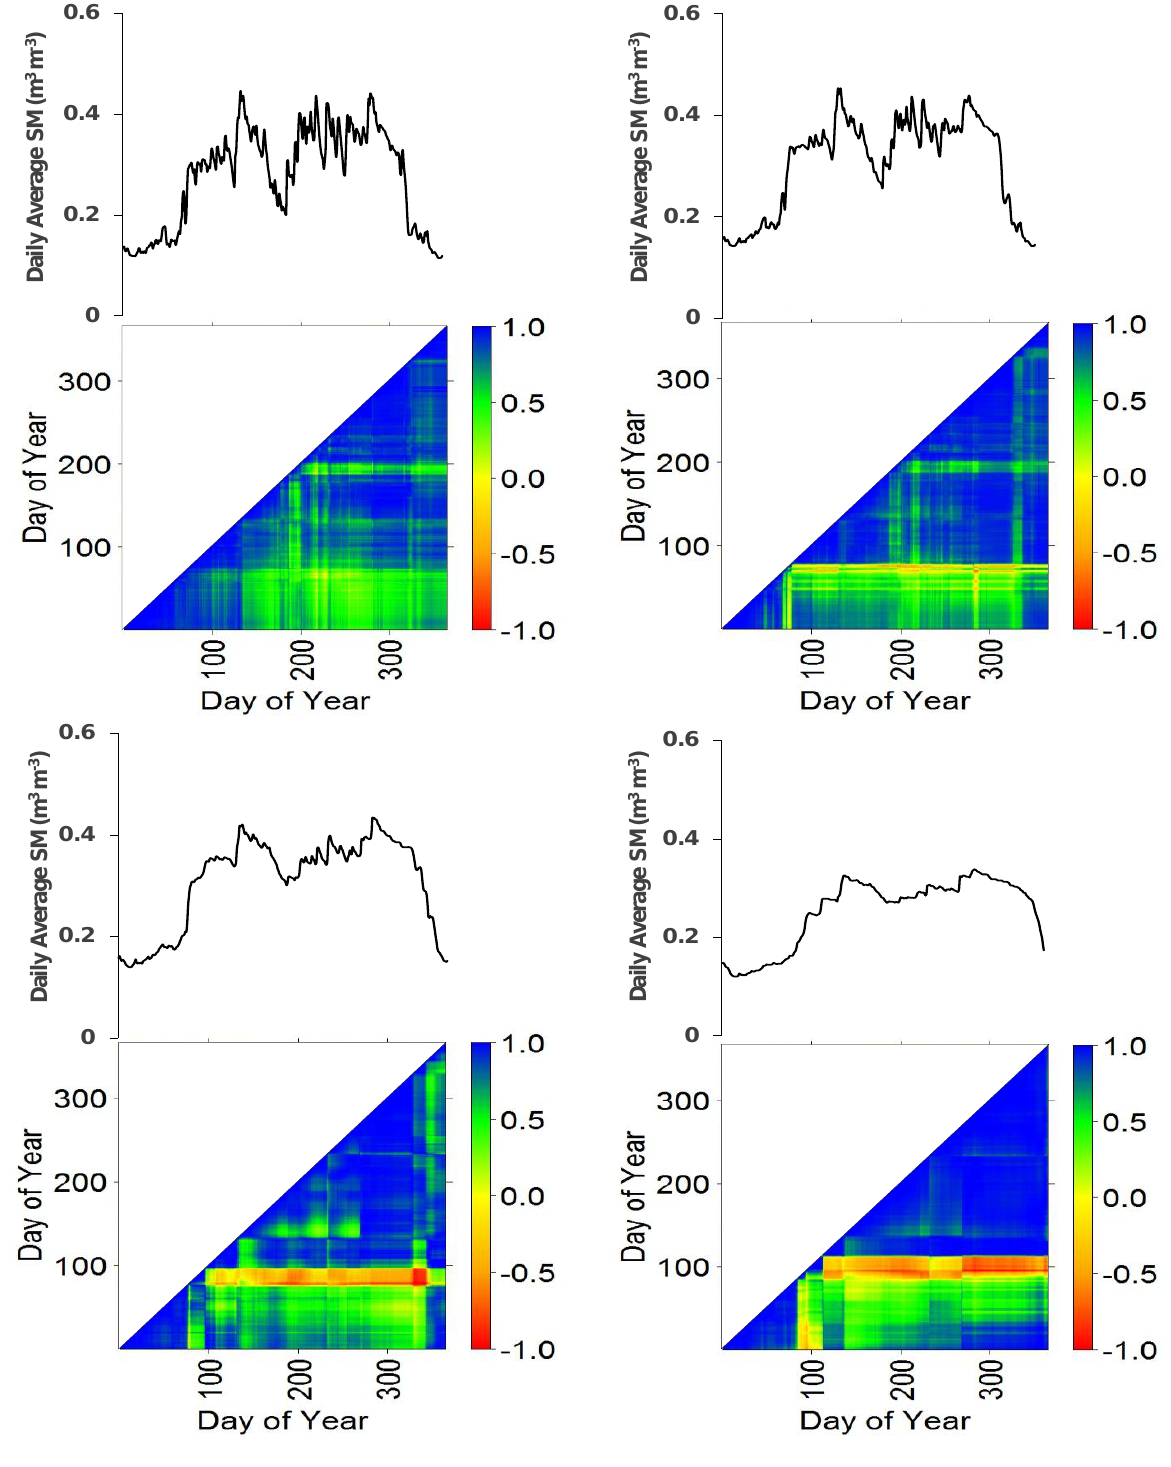
Figure 4. Triangular matrix of Pearson correlation coefficient (Equation (5)) at respective depth by day of year (day 1 is January 1st,